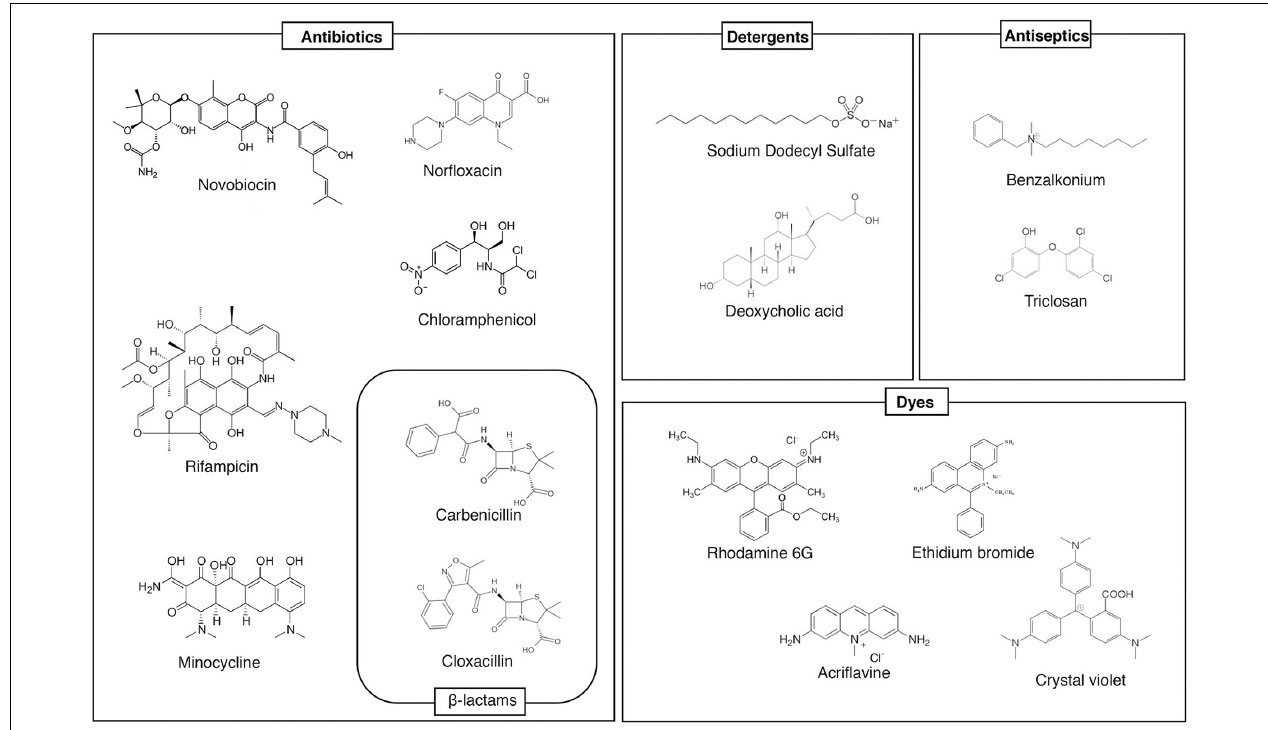
FIGURE 2 | Examples multidrug efflux pump substrates. This figure shows example substrates of AcrB, a multidrug efflux pump. It recognizes many structurally unrelated antibiotics/toxins, and extrudes them from the cell, contributing to multiple drug